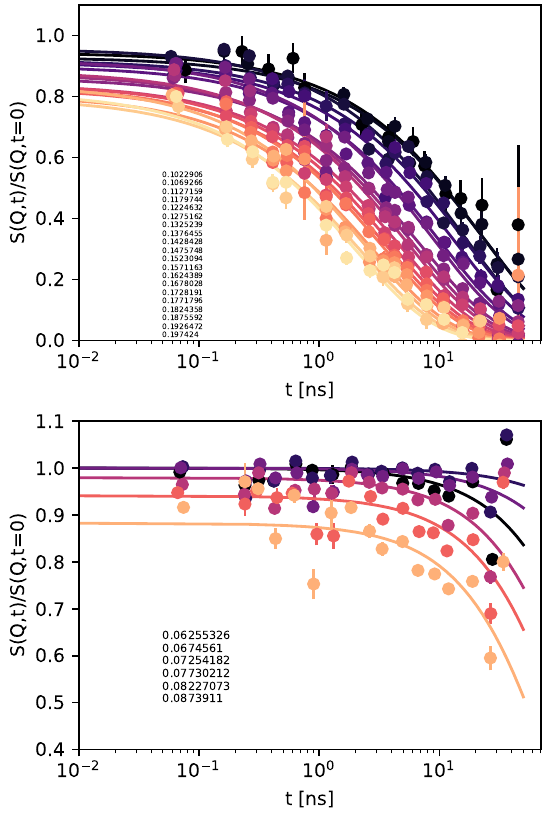
Figure 3. Intermediate scattering function S(q,t) / S(q,0) for a bi- continuous (top) and an oriented lamellar microemulsion (bot- tom).